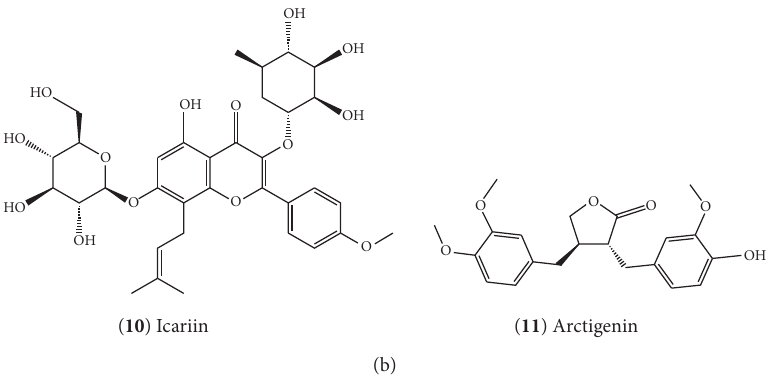
Figure 1: The HPLC chromatogram and the chemical structure of eleven markers of KIOM-MA/MA128. (a) The HPLC chromatogram of KIOM-MA/MA128. (b) The chemical structure of eleven markers of KIOM-MA/MA128.